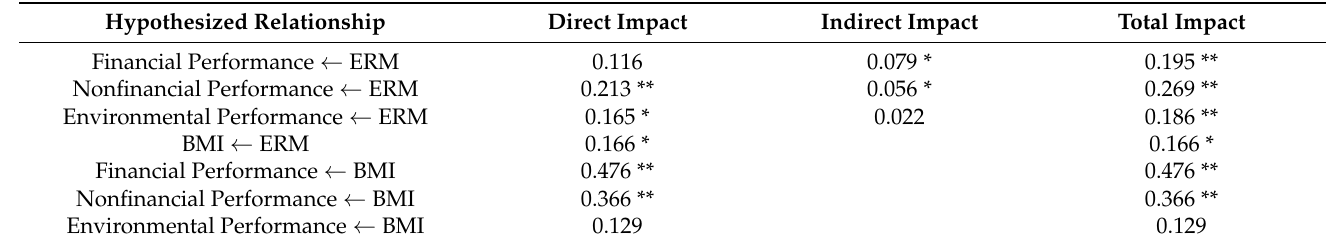
Table 5. Hypotheses testing.